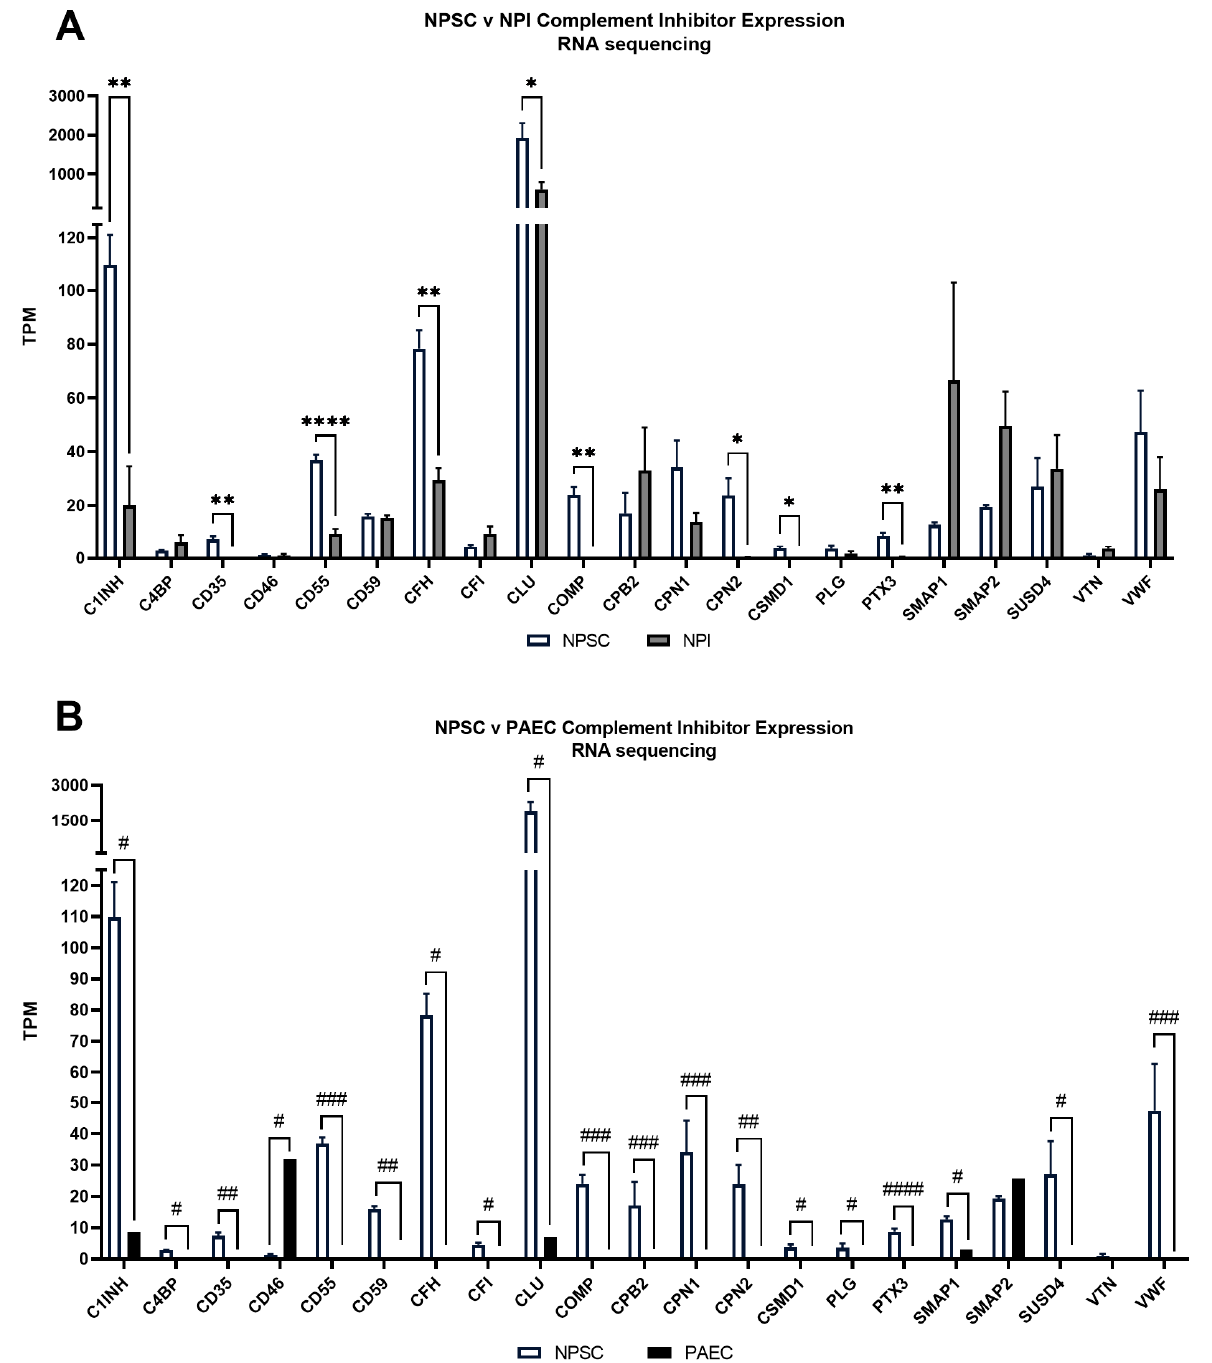
Figure 4. NPSCs express 21 complement inhibitor genes. ( A ) RNA sequencing identified NPSCs (white bars) express nine complement inhibitor genes at significantly elevated levels compared to NPIs (gray bars). Statistical significance was determined with unpaired t -test. Numerical values are contained in Table S2. Asterisks denote significance. * p ≤ 0.05. ** p ≤ 0.01. **** p < 0.0001. ( B ) Mean comparison of RNA sequencing for complement inhibitor genes between NPSCs (white bars) and PAECs (black bars). Log 2 Fold Change (LFC) was calculated between Sertoli cells and endothelial cells for comparison of data sets. Numerical values are contained in Table S3. Pound sign denotes significance. # LFC > 1. ## LFC > 5. ### LFC > 10. #### LFC >